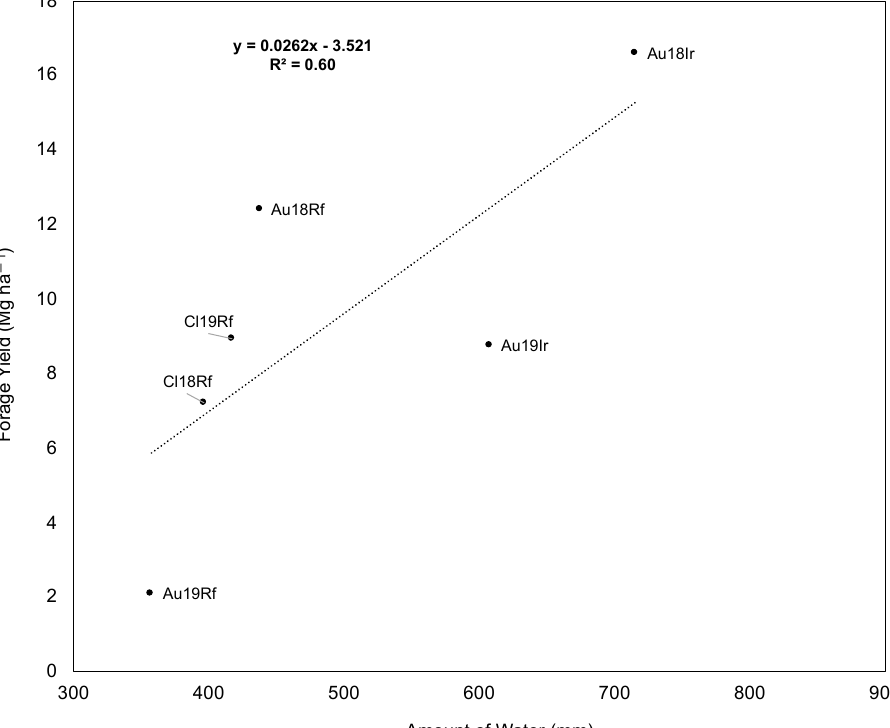
Figure 4. Frequency distribution (box plot; A ) and GGE biplot ( B ) of annual forage yield evaluated in 30 alfalfa accessions in drought-prone environments of Chile and Australia during the first and second growing season after the establishment year. GGE biplot corresponds to the first two principal components (PC1 and PC2) for the principal component analysis of annual forage yield evaluated in six environments: rainfed experiment in Australia in 2017–2018 (Au18Rf) and 2018–